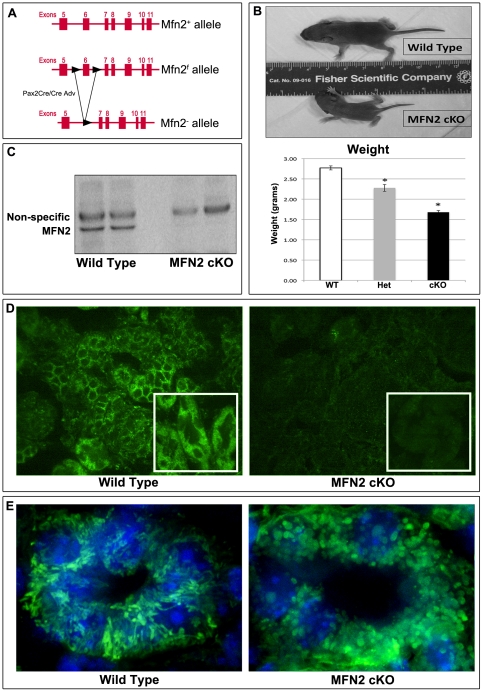
Generation and phenotype of MFN2 cKO mice.(A) Two LoxP sites flank exon 6 in the region coding for the canonical G-1 GTPase motif are shown. Cre recombinase excises exon 6 that causes a frame shift which precludes functional protein production. For in vivo experiments, animals were crossed with Pax2-Cre expressing mice creating MFN2 conditional knockouts (MFN2 cKO). (B) MFN2 cKO mice are significantly smaller than wild type littermate controls. * P<0.05 vs. WW; n≥8 per group. (C) MFN2 content in wild type and MFN2 cKO kidney homogenates. The MFN2-specific band is absent in homogenates harvested from MFN2 cKO mice. (D) MFN2 immunofluorescence staining in littermate wild type and MFN2 knockout kidney sections. MFN2 staining is absent in MFN2 cKO animals; 200× magnification (inset: 400× magnification). (E) Immunostaining for F1F0-ATPase, an intrinsic mitochondrial membrane protein, in wild type and MFN2 cKO kidney; mitochondria(white arrows) in tubule epithelia of MFN2 cKO mice appear fragmented and punctate compared to wild type littermates. Hoechst dye was used to stain tubule cell nuclei.